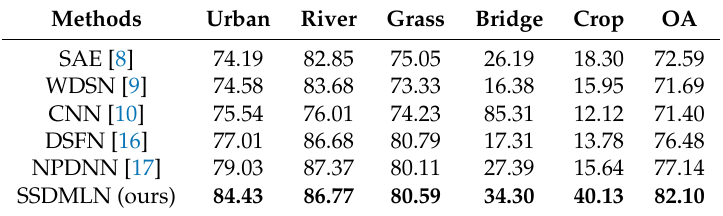
Figure 7. Comparison of classification results on the Xi’an data set using 1% labeled data. ( a ) PauliRGB image. ( b ) Ground truth. ( c ) SAE [8]. ( d ) WDSN [9]. ( e ) CNN [10]. ( f ) DSFN [16]. ( g ) NPDNN [17]. ( h ) SSDMLN (ours). Table 4. Classification results (%) on the Xi’an data set with 1% labeled